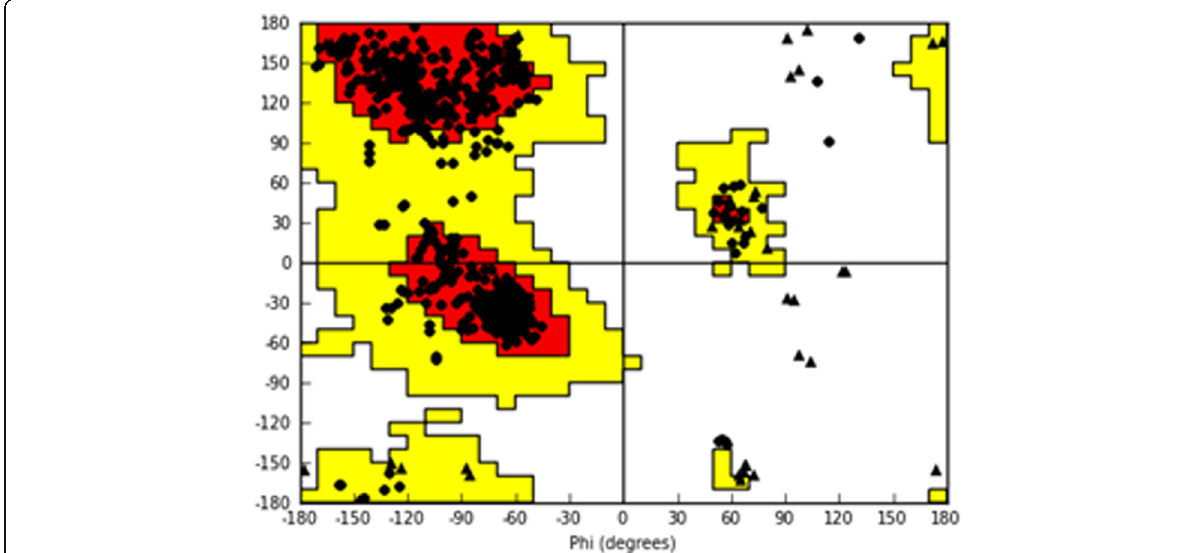
Fig. 2 Ramachandran plot for the Tc IDH2 homology model. The amino acids are represented as circles, except for glycine, represented as triangles. The white area shows sterically disallowed regions for all amino acids, except glycine. The yellow areas show the sterically allowed regions. The red areas indicate the most sterically favorable regions, i.e. regions where amino acids conformations have no steric